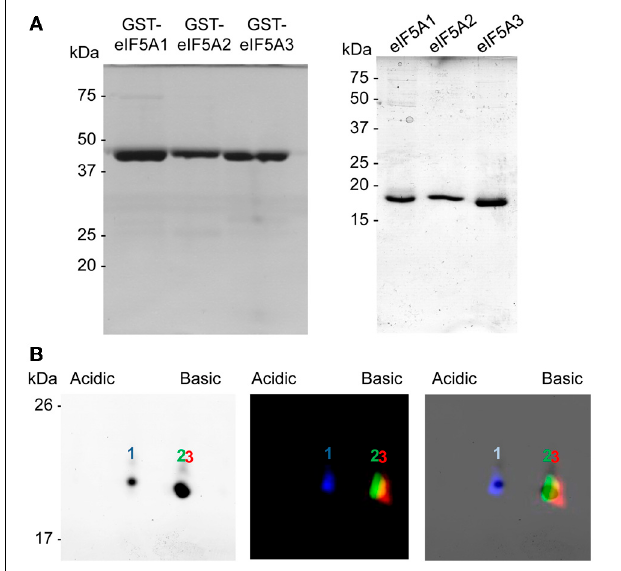
FIGURE 1 | Recombinant protein expression and 2D-E separation of non-modified eIF5A proteins. (A) GST-fusion proteins (left) or GST-cleaved eIF5A (right) recombinant proteins were separated by 1D SDS-PAGE and coomasie stained. (B) Recombinant eIF5A proteins were labeled with fluorescent dyes eIF5A1-Cy2, eIF5A2-Cy3, and eIF5A3-Cy5, mixed and separated by 2D-E for coomassie staining (left) or fluorescent scanning (middle), and both images were merged